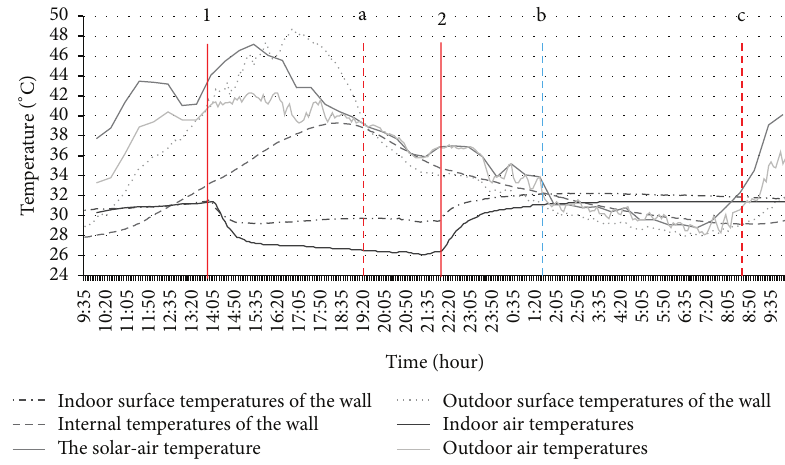
Figure 3: Testing-point temperatures of externally insulated wall in daytime running state of air-conditioner.